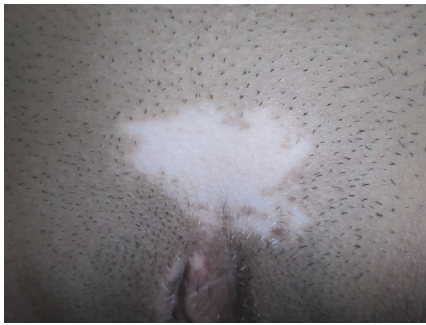
Figure 2: Depigmented patch with leukotrichia on mons pubis.